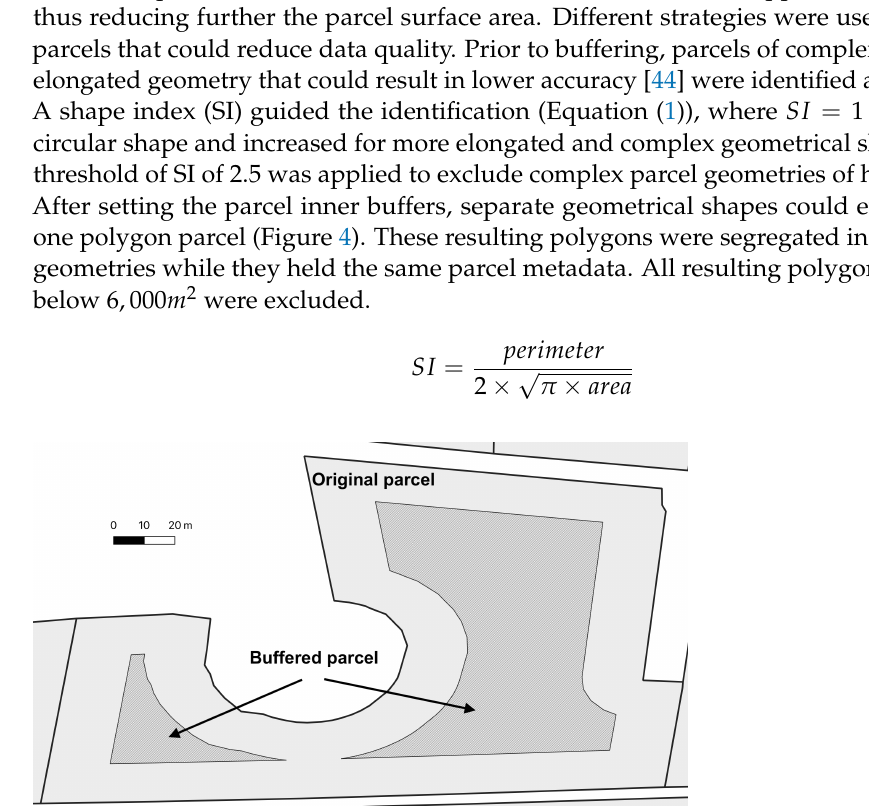
Figure 4. An example of a parcel polygon (SI is 1.61), resulting in two separate polygon geometries due to a 20 m inner